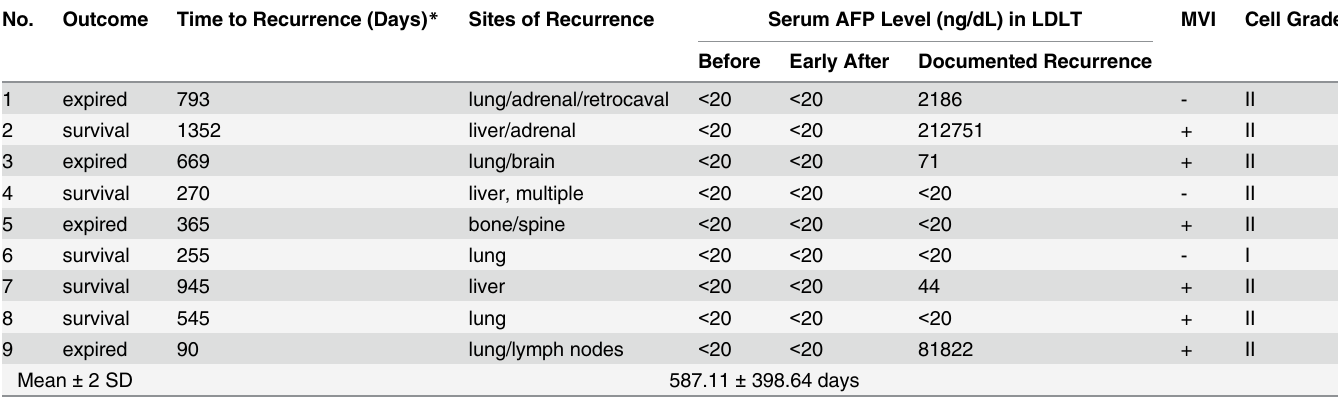
Table 1. Clinical data of the nine living donor liver transplant recipients with recurrence of hepatocellular carcinoma.